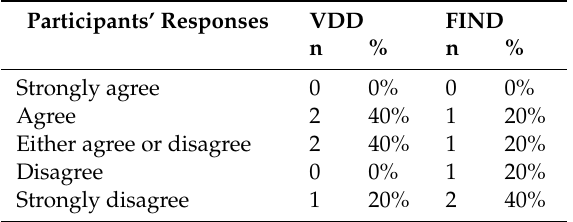
Table 10. Participants’ opinions about the results of the spatial data